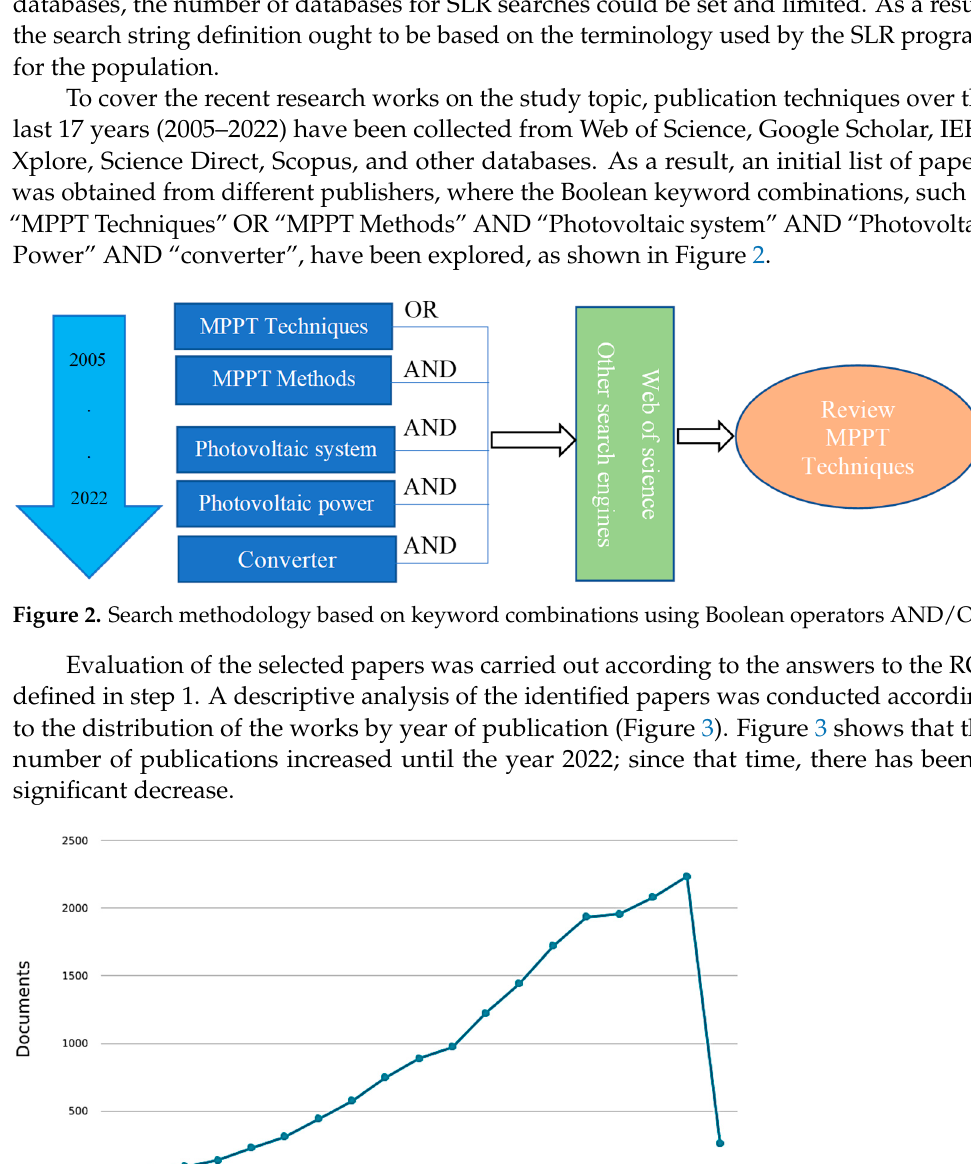
Figure 3. Distribution of papers according to year of publication from 2005 to 2023.